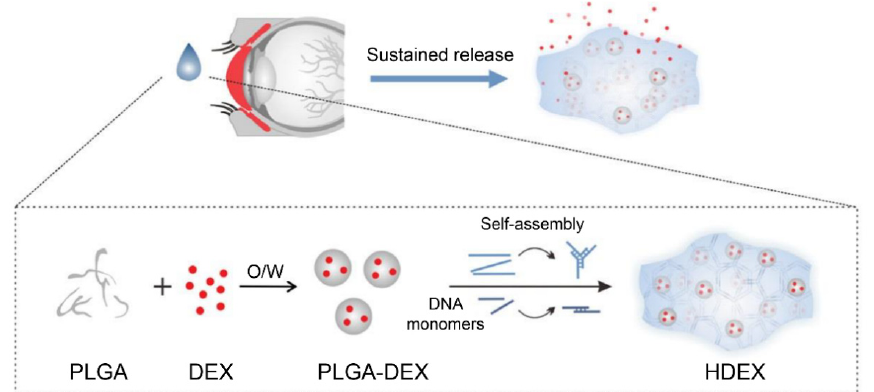
Figure 3. DNA hydrogel-mediated sustained release of DEX in ophthalmic tissues. (Adapted with permission from [59]. Copyright (2019) American Chemical